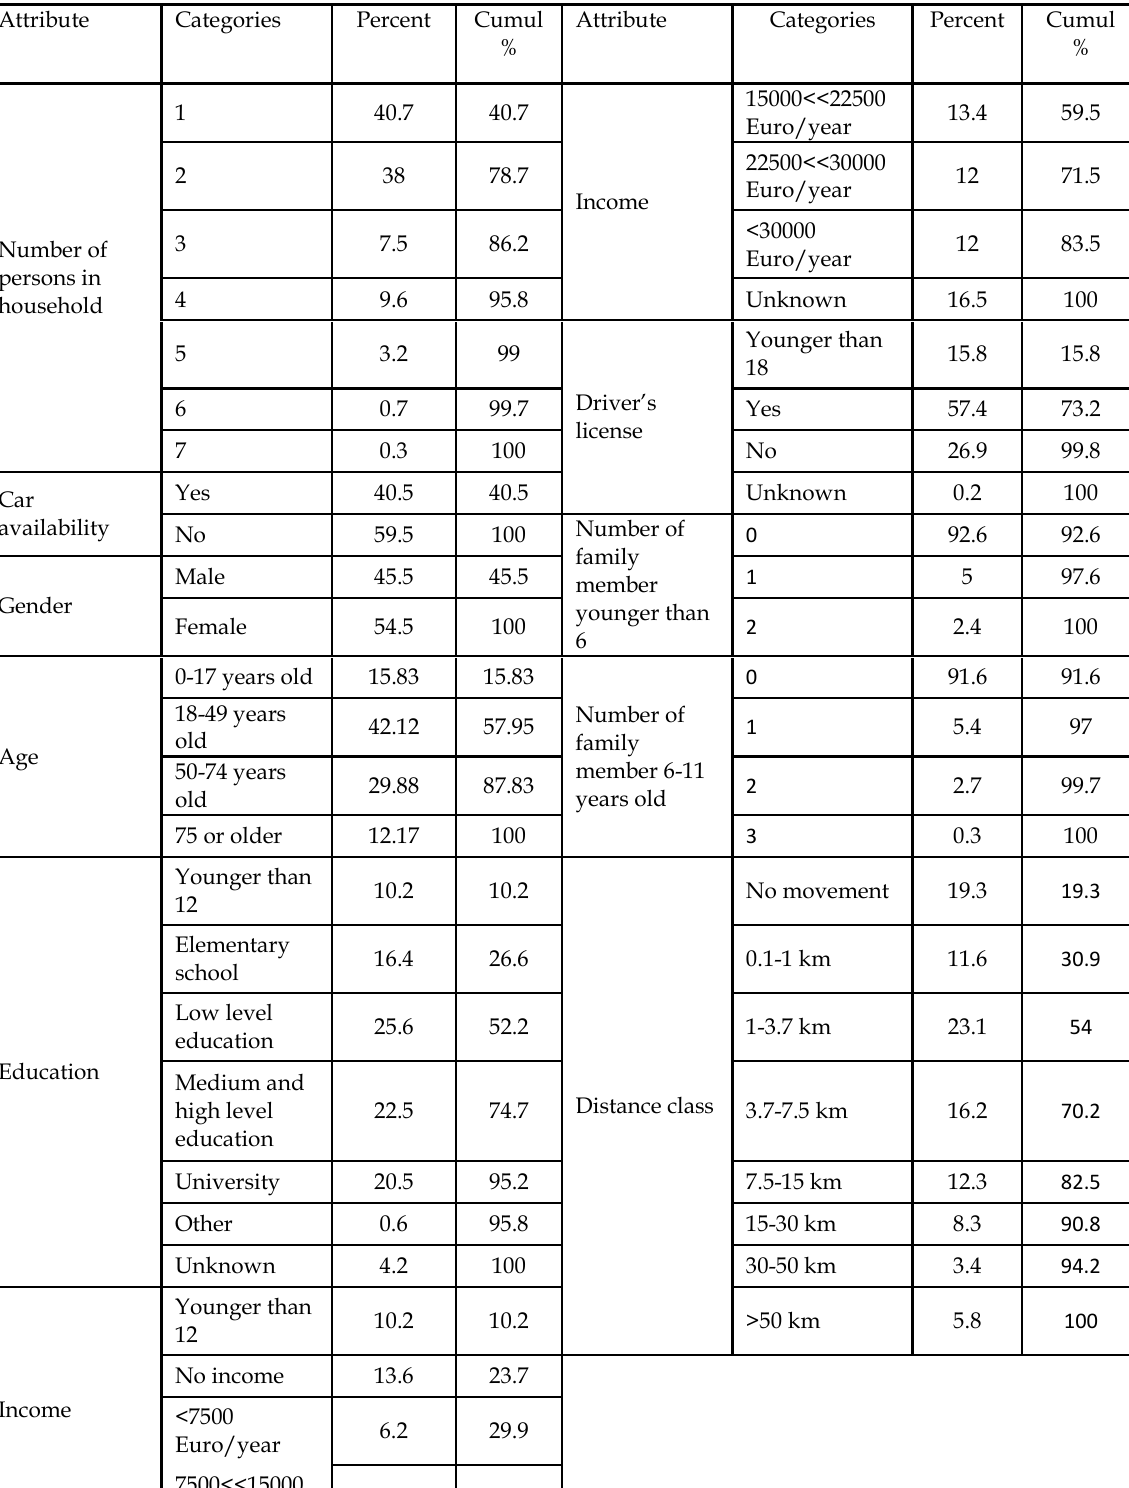
Table 1. Frequency distributions of selected